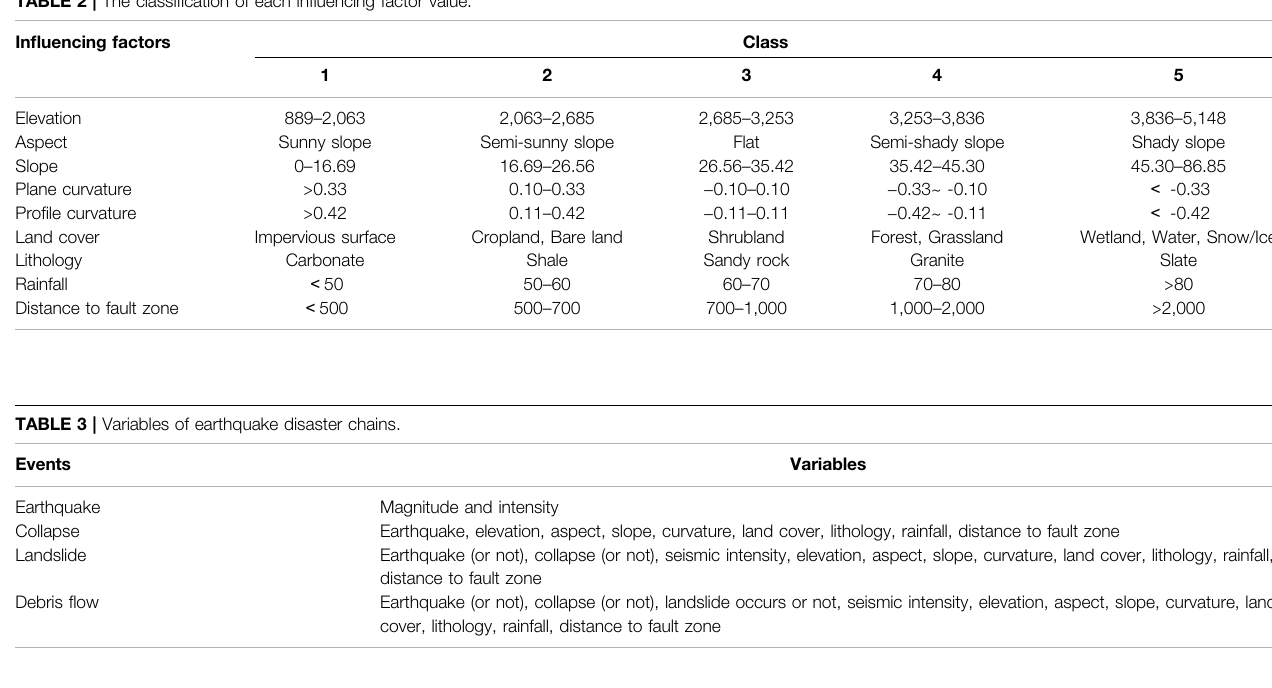
TABLE 2 | The classi fi cation of each in fl uencing factor value.